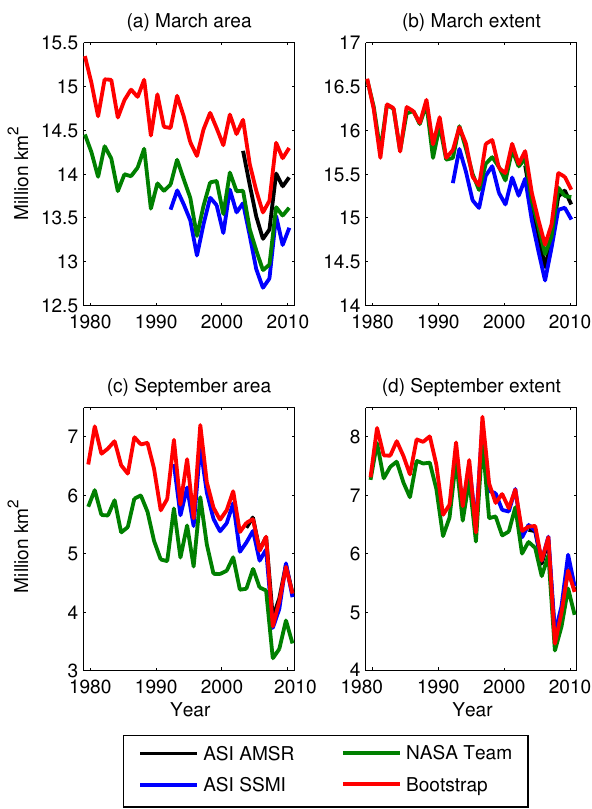
Fig. 2. September and March sea-ice area and sea-ice extent as re- trieved from satellite for the period 1979–2010. Different colors denote different algorithms or satellites. Area and extent were cal- culated based on sea-ice concentration fields on EASE grids with 25km resolution (NASA Team and Bootstrap, based on SMMR and SMM/I, 1979–2010), 12km resolution (ASI SSM/I, 1992–2010) and 6km resolution (ASI AMSR-E, 2002–2010).